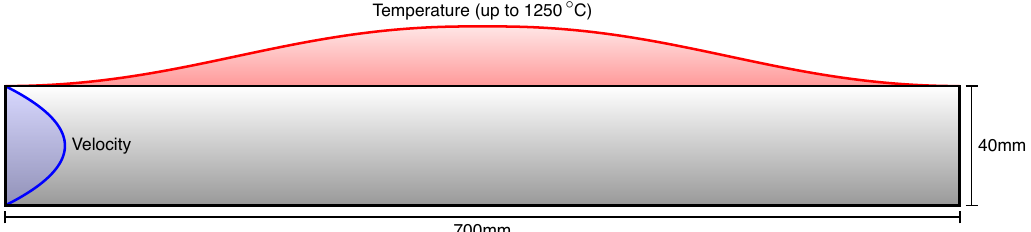
Figure 10. Diagram of the reactor, not to scale. Working fluid enters on the left and is heated up as it flows downstream. The temperature peaks at the middle of the reactor at